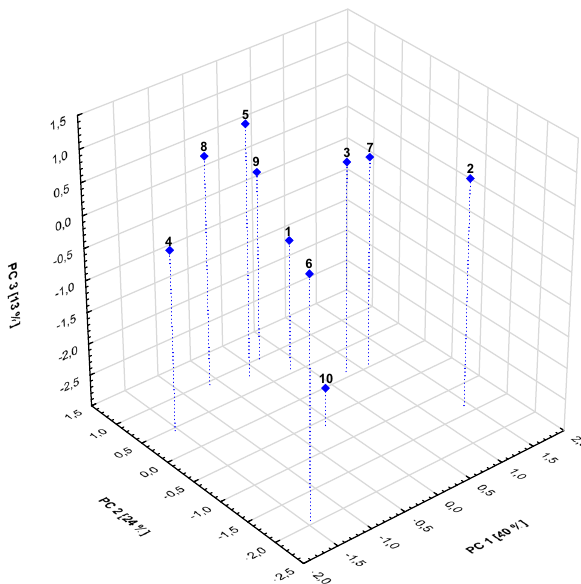
Figure 1: Distribution of the studied African medicinal plants sam - ples in 3D plot of PC1, PC2, and PC3.